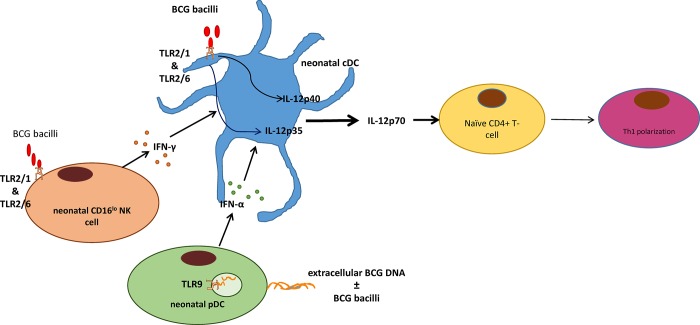
Illustrative model demonstrating how the Bacille Calmette Guérin (BCG) vaccine might drive interleukin (IL)-12 p35 and p40 (IL-12 p70) production and CD4+ T-cell T-helper 1 (Th1) polarization in neonates.IFN = interferon; cDC = conventional dendritic cell; NK = natural killer; pDC = plasmacytoid dendritic cell; TLR = Toll-like receptor.